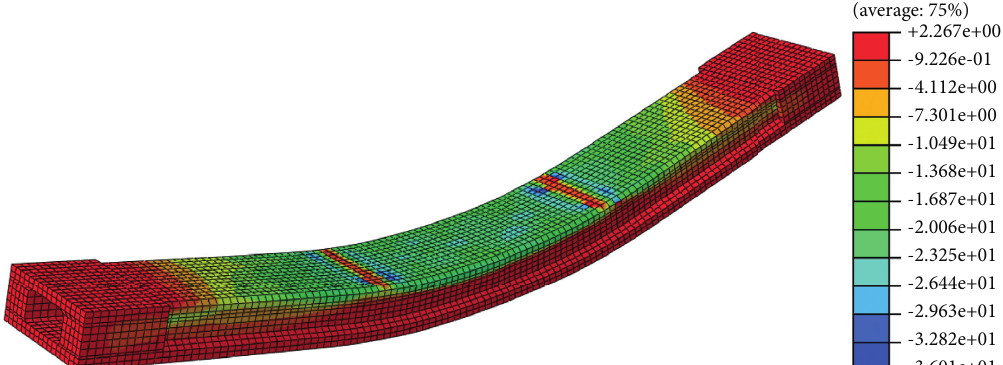
Figure 19: The failure mode of hollow slab strengthened by